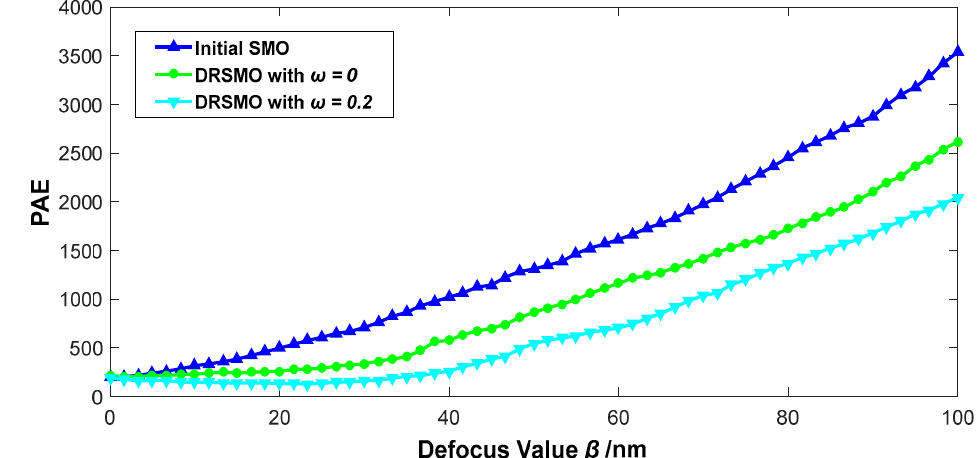
Figure 6. The defocus–PAE curves of target 2 for initial SMO (blue curve), the DRSMO with the weight factor ω = 0 (green curve) and ω = 0.2 (azury curve), respectively. Optimizations were proceeded by the MBGD algorithm.